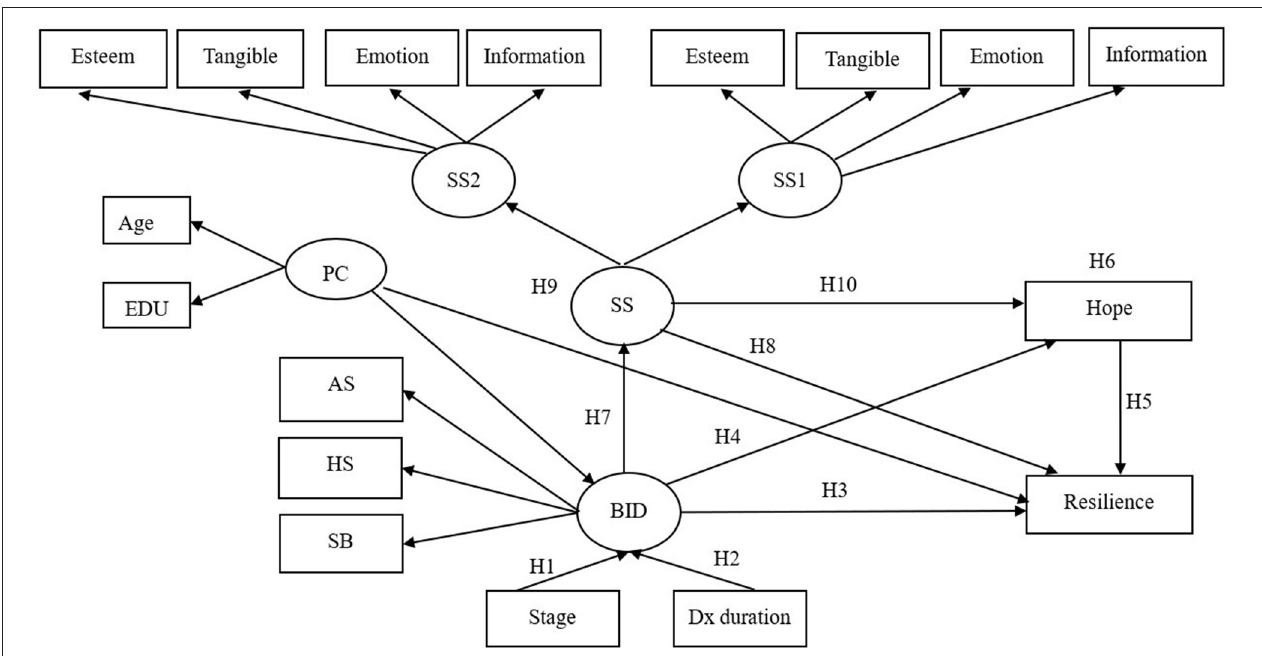
FIGURE 1 | Conceptual framework of hypothesized model. PC, personal characteristic; EDU, education; BID, body image distress; SB, social barriers; AS, physical appearance and sexual life; HS, Health and strength; Stage, disease stage; Dx duration, time since breast cancer diagnosis; SS, social support; SS1, social support from family and friends; SS2, social support from health professionals; = latent variable; = measured variable; → = unidirectional